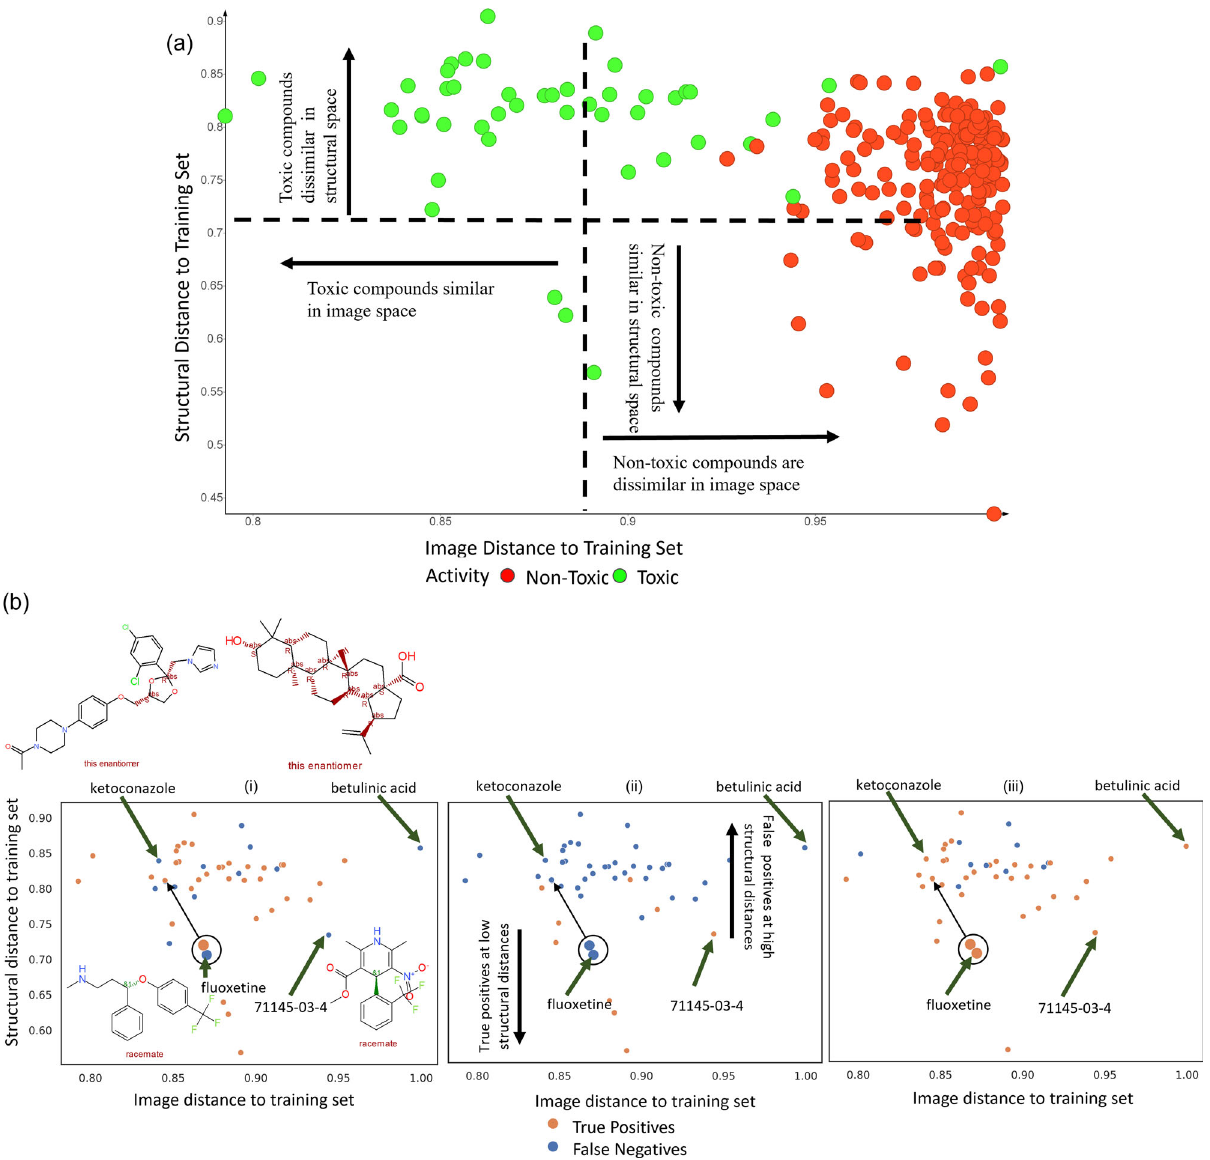
Fig. 9 Predictions of mitochondrial toxicants in the external test set in relation to structural and morphological distance to training set. a Most mitotoxic compounds are similar in image space for training ( n = 382 compounds) and external test set ( n = 244 compounds), however, non-toxic compounds in the external test set were dissimilar to non-toxic compounds in training set in the image space. Further, toxic compounds are often dissimilar in structural space, indicating the need for fusion models. b Structural and morphological distance for mitotoxic compounds in external test set ( n = 244 compounds) to the training set ( n = 382 compounds) for models using (i) Cell Painting features, (ii) Morgan fi ngerprints and the (iii) Late-stage fusion models. Morgan fi ngerprints failed to correctly classify mitotoxic compounds (eg. betulinic acid) at high structural distances while models using Cell Painting features could extrapolate well into structurally diverse compounds. The late-stage fusion models correctly classi fi ed mitotoxic compounds (e.g. 71145-03-4 or methyl 2,6-dimethyl-5-nitro-4-[2-(tri fl uoromethyl)phenyl]-1,4-dihydropyridine-3-carboxylate, ketoconazole and fl uoxetine) in both diverse morphological and structural space where individual models failed demonstrating the synergistic effect of the features